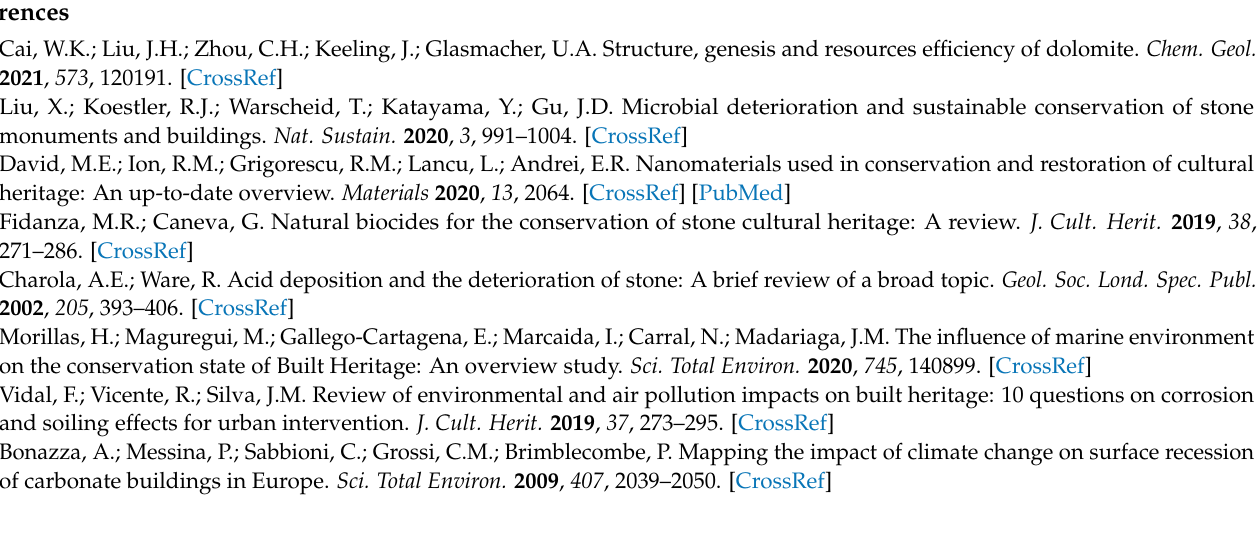
Figure S2: The SEM of dolomite after different additive content solution B treatment (a) 0.0001mol, (b) 0.0002mol, (c) 0.0003mol, (d) 0.0004mol, (e) 0.0005mol; Figure S3 The SEM of dolomite after solution B treatment (a) spray, (b) poultice, (c) brush; Table S1: Chromatic value of